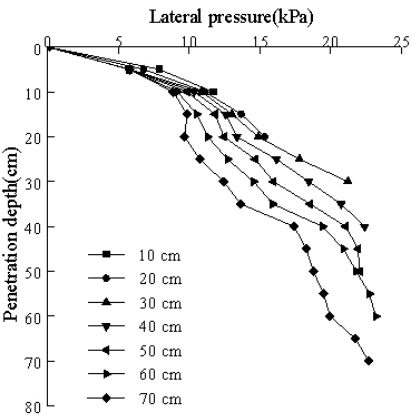
Figure 11. Relationship between the lateral pressure and penetration depth at different pile pressing depths.